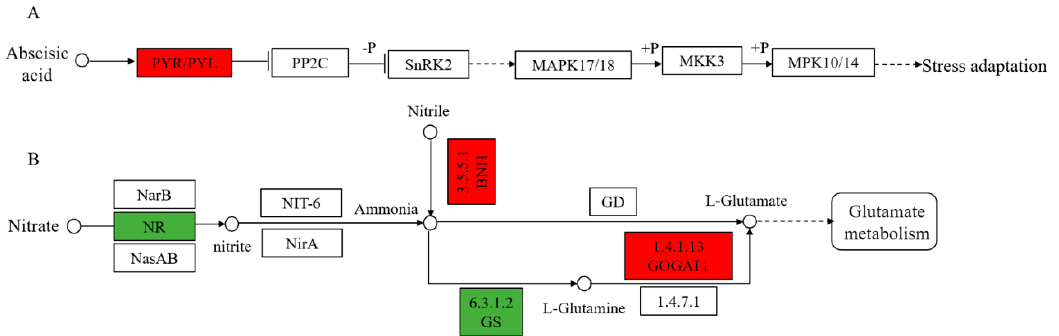
Figure 7. ( A ) MAPK signaling pathway in the response of 8723 to salt stress. ( B ) Nitrogen metabolic response to salt in P138. The red box indicated that the protein was up-regulated under salt stress, and green boxes represent down-regulated proteins under salt stress. Abbreviation: PYR/PYL: pathogenesis-related protein 10, NR: nitrate reductase, GS: glutamine synthetase, GOGAT1: Glutamate synthase 1, NBH: Bifunctional nitrilase/nitrile hydratase NIT4.